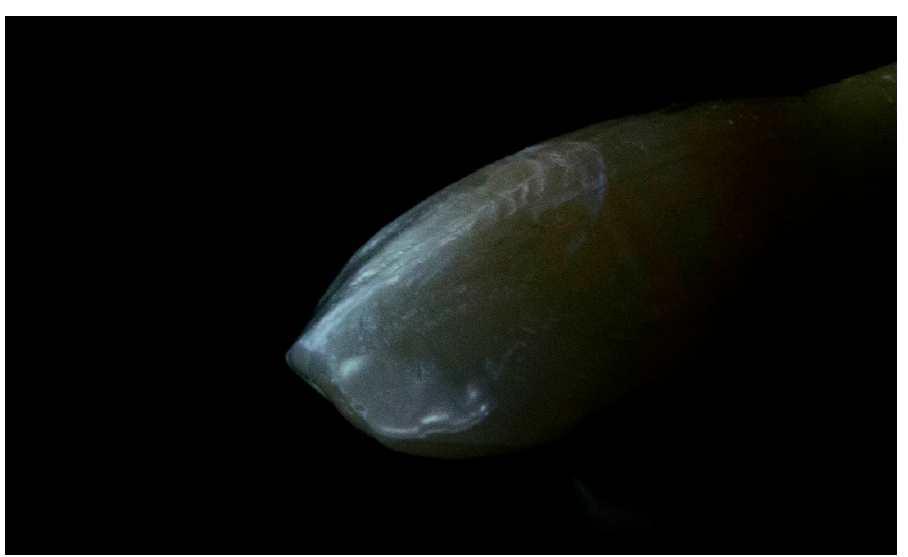
Figure 4. After de-bonding tooth surface. After the de-bonding, all the teeth were grouped, and de-bonding was evaluated by a blinded single operator. Each tooth was classified using a modified ARI (Adhesive Remnant Index) scale from 0 to 2 with the use of 5.0 × /235 telescopic head-worn magnifier as follows.